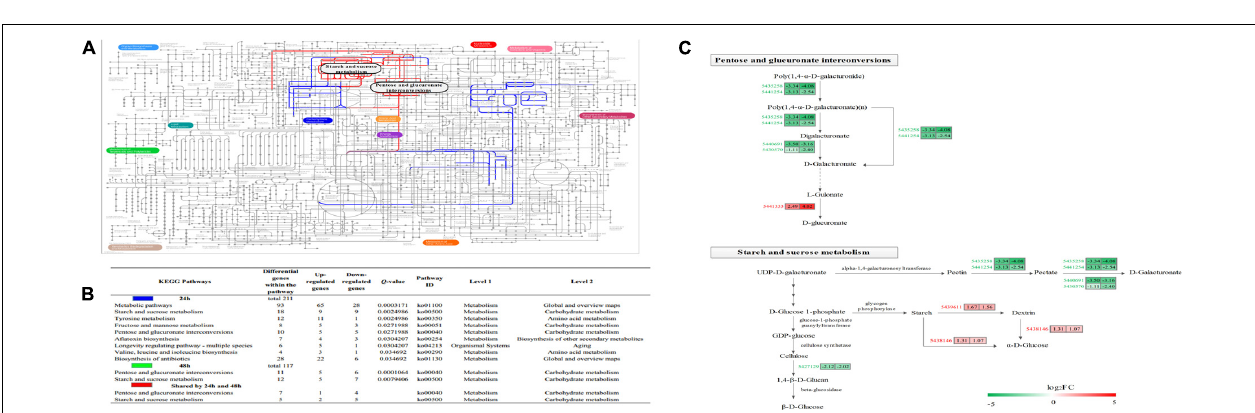
FIGURE 5 | Characterization of the Botrytis cinerea transcriptome. (A) Projection of the Botrytis cinerea transcriptome on the KEGG pathways using iPath (Letunic et al., 2008). Significant pathways at 24 and 48 h are shown in blue and green, respectively. Red lines correspond to shared pathways at 24 and 48 h. Note: Green lines are covered by red lines. (B) Detailed information about the KEGG enrichment analysis of the DEGs. (C) Abundance patterns of the genes participating in the shared pathways. Annotations of the genes are available in Supplementary Table S5 .